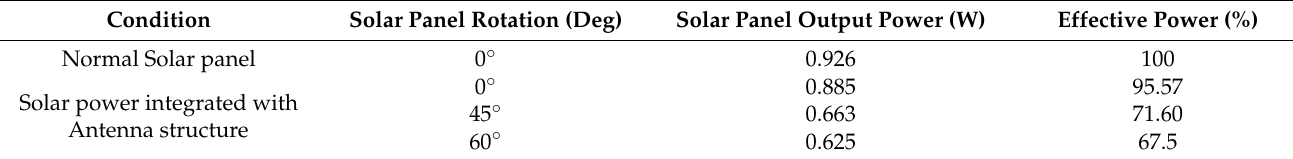
Table 3. Comparison between proposed antenna and existing lower UHF antennas.